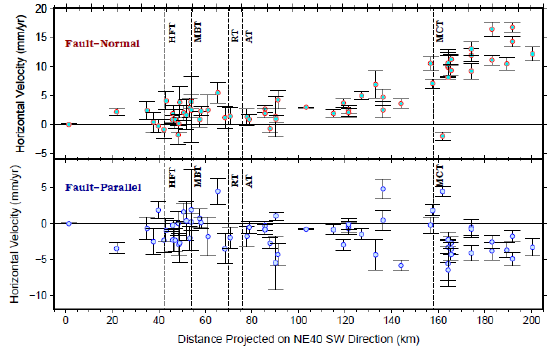
Figure 3. Fault-normal (red) along N40°E and Fault- Parallel component (blue) across N40°E after fixing THKD station along the N290°E fault strike of the Himalayan arc.